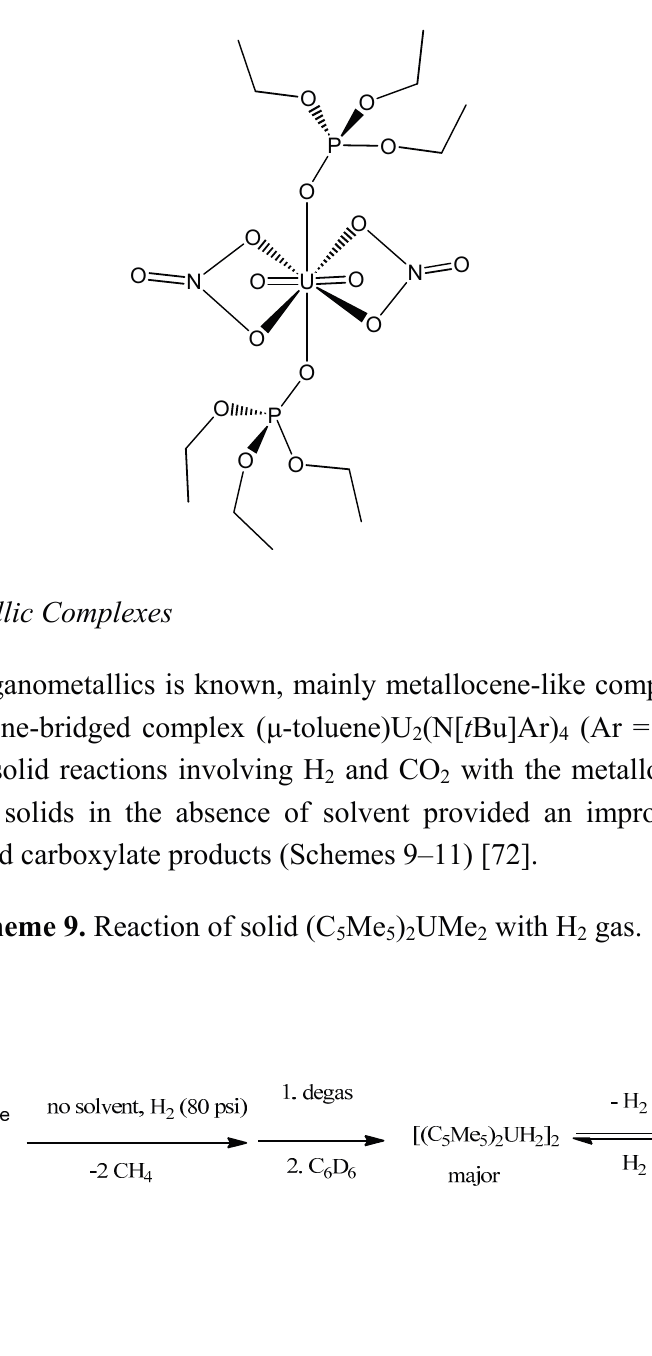
Figure 28. Schematic diagram of complex structure UO